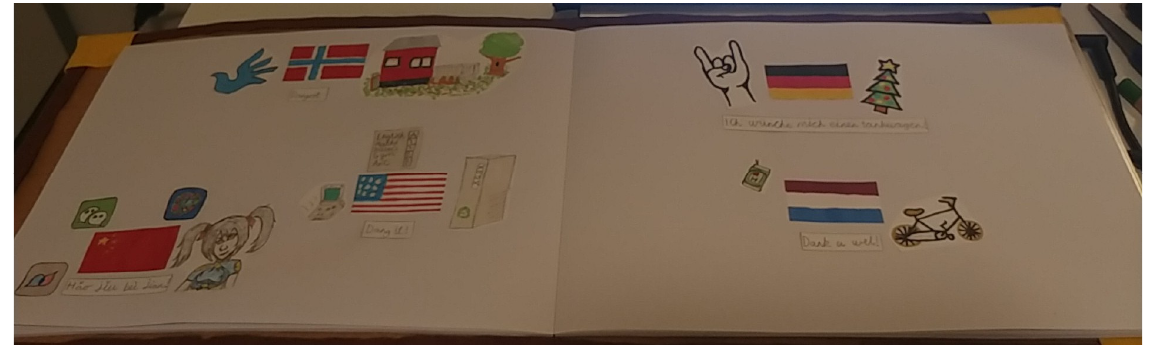
Figure 5. ST12’s DLC artefact.